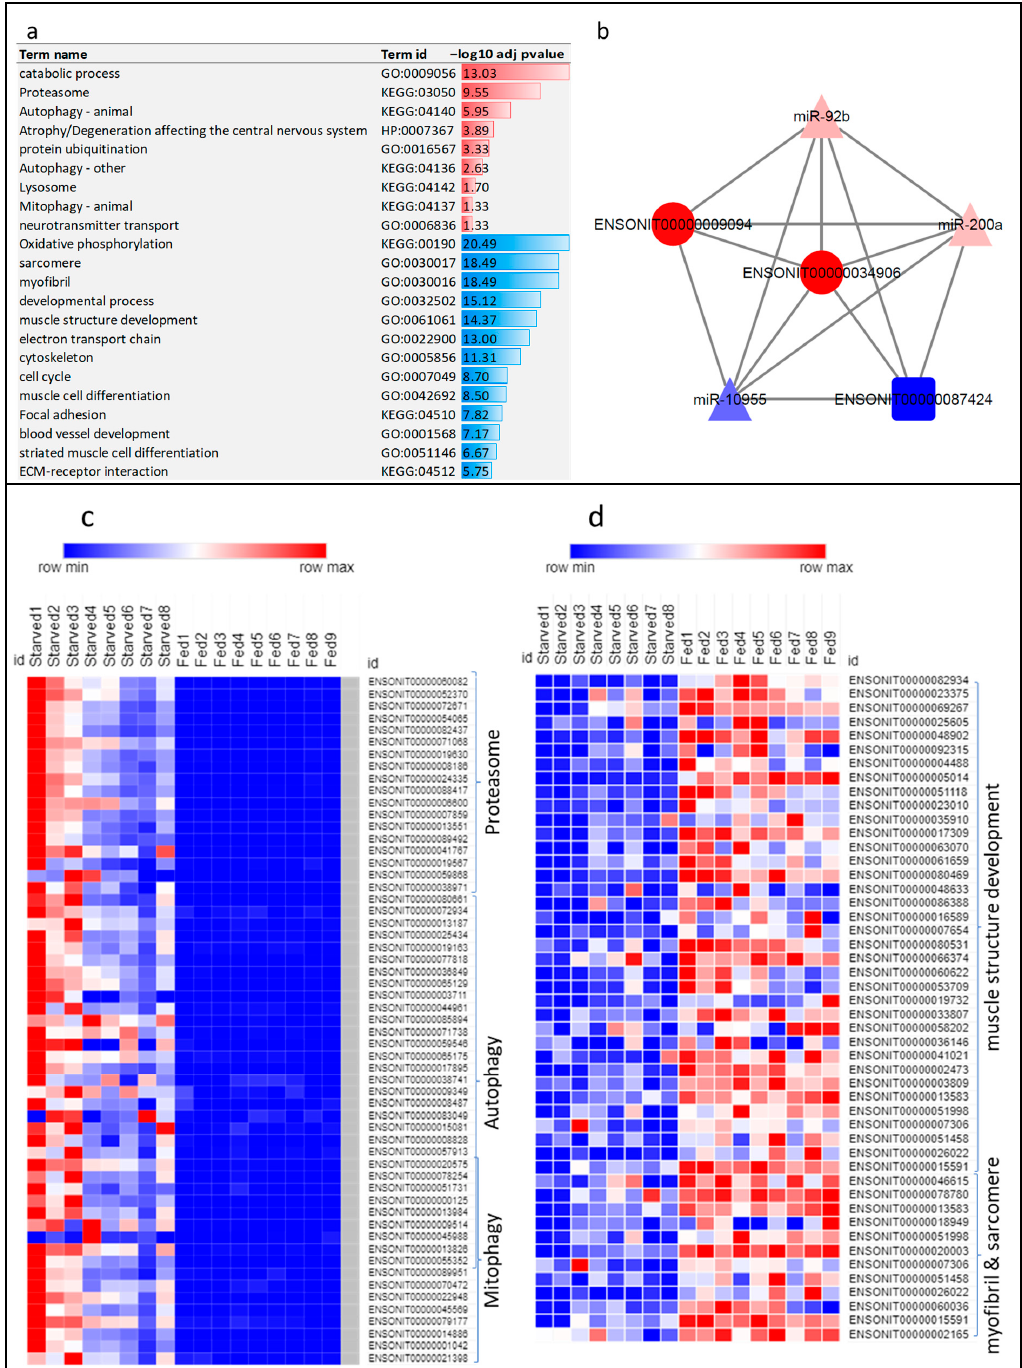
Figure 3. ( a ) Enrichment analysis of differential transcripts following starvation. Over-represented KEGG pathways and GO terms are represented in red, whereas under-represented KEGG pathways and GO terms are represented in blue. Negative log10 of adj p -values are plotted. ( b ) Interaction network between FBXO32 transcripts and noncoding transcripts (lncRNA and microRNAs) exhibit- ing correlation in expression. FBXO32 transcripts and the lncRNA ENSONIT00000087424 share similar microRNA binding sites. ( c ) Heatmap showing expression pattern of starvation-upregulated transcripts involved in proteasome, autophagy, and mitophagy (fold change > 4). ( d ) Heatmap showing expression pattern of starvation-downregulated transcripts involved in muscle structure development and myofibril and sarcomere (fold change < −